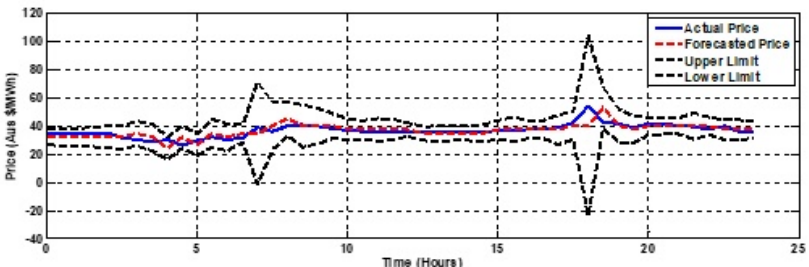
Figure 15. Winter weekdays plot of Tuesday (7 July 2015) without selected features with a MAPE of 6.88.